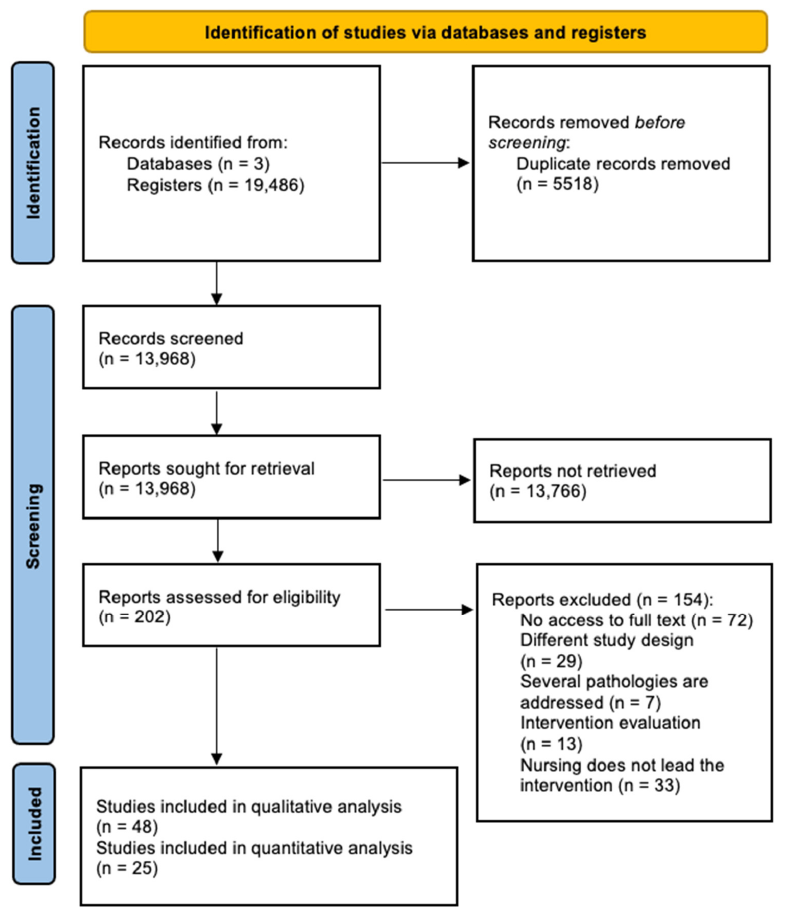
Figure 1. PRISMA flowchart of the study selection process.